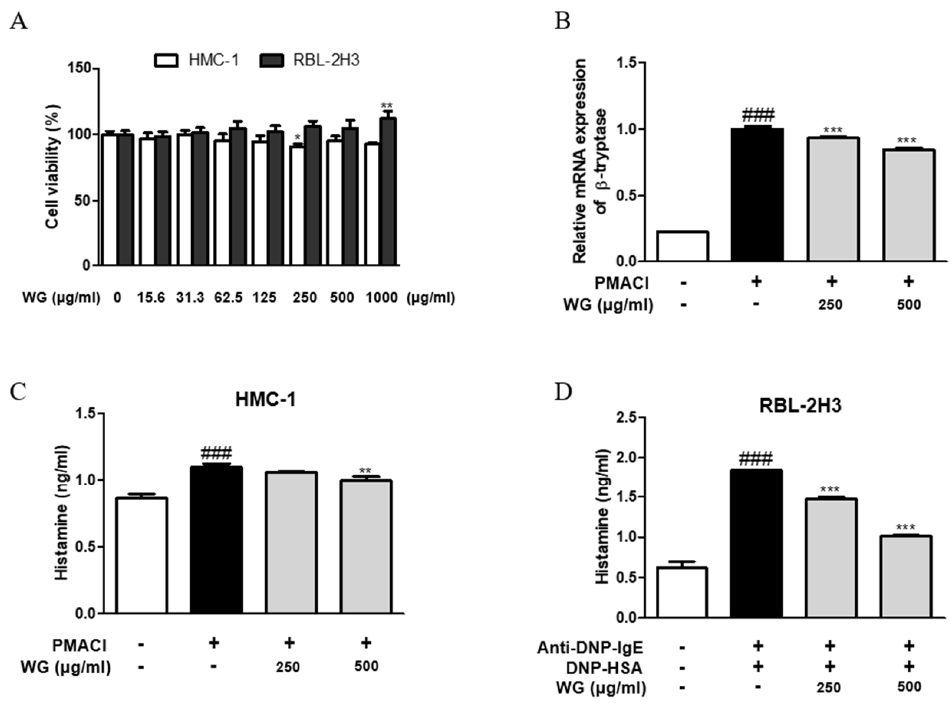
Figure 3. Effects of WG on the allergic mediators in PMACI-stimulated HMC-1 and RBL-2H3 cells. ( A ) HMC-1 and RBL-2H3 cells were treated with different concentrations of WG and the cell viability levels were determined using MTS/MTT assay. Note: * p < 0.05 and ** p < 0.01 vs. the non-treated group. ( B ) The mRNA level of β -tryptase was determined by quantitative qRT-PCR. ( C , D ) Histamine release was measured using ELISA kit. The data shown represent means ± S.D. of three independent experiments. Note: ### p < 0.001 vs. the control group; ** p < 0.01 and *** p < 0.001 vs. stimulator ‐ treated group.